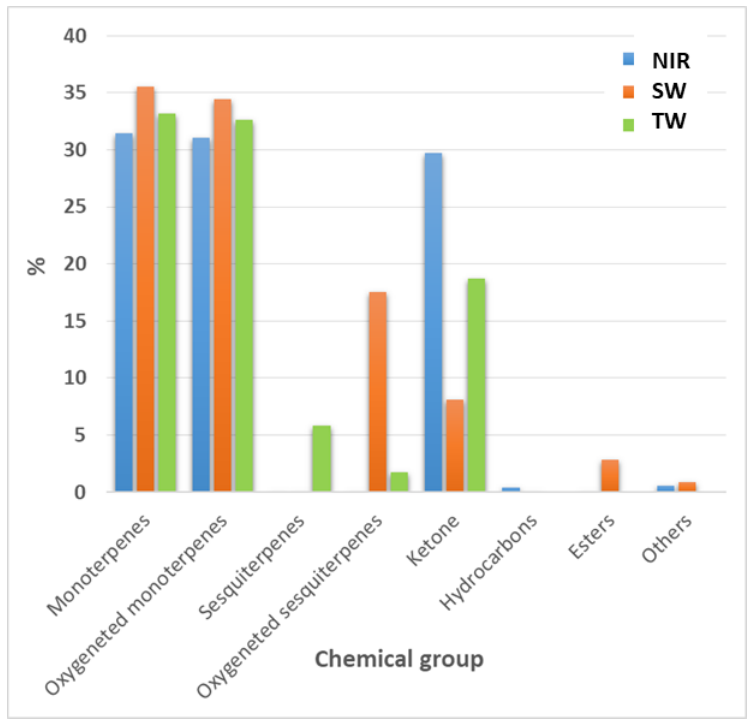
Figure 3. Essential oil chemical groups of Rosmarinus officinalis plants subjected to various irrigation treatments. (NIR: Not Irrigated, SW: Irrigated with salt water, TW: Irrigated with tap water).